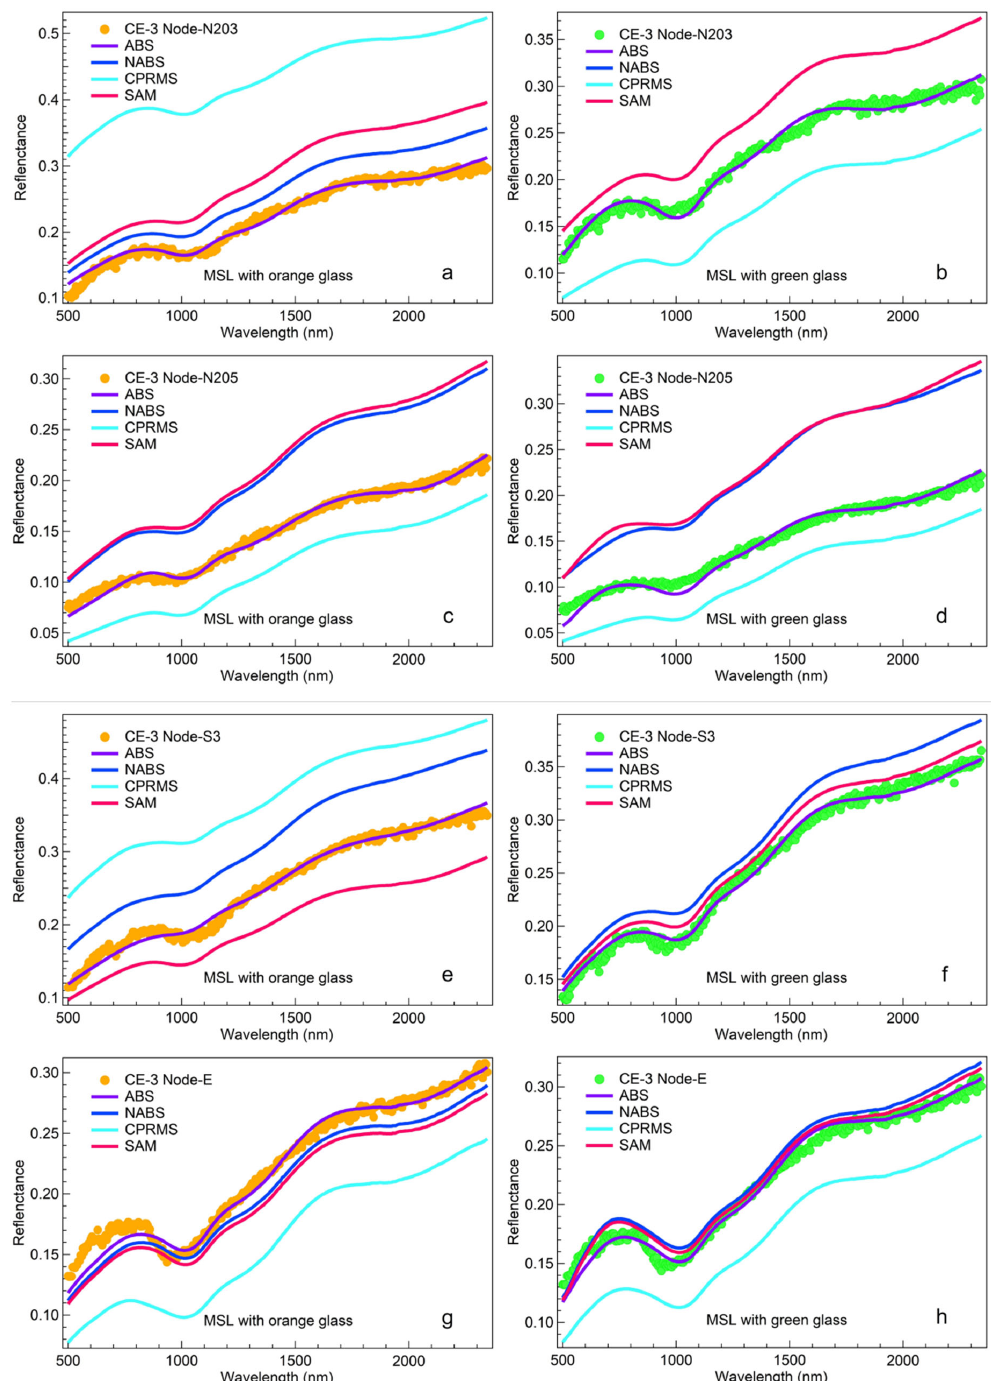
Figure 7. Comparisons of the CE-3 sample spectra with the corresponding best-matched MSL spectra (green or orange glass) were obtained using four different fitting metrics (Equations (15)–(18)). The results shown in ( a , c , e , g ) and those in ( b , d , f , h ) are obtained using the MSL with orange and green glasses, respectively.